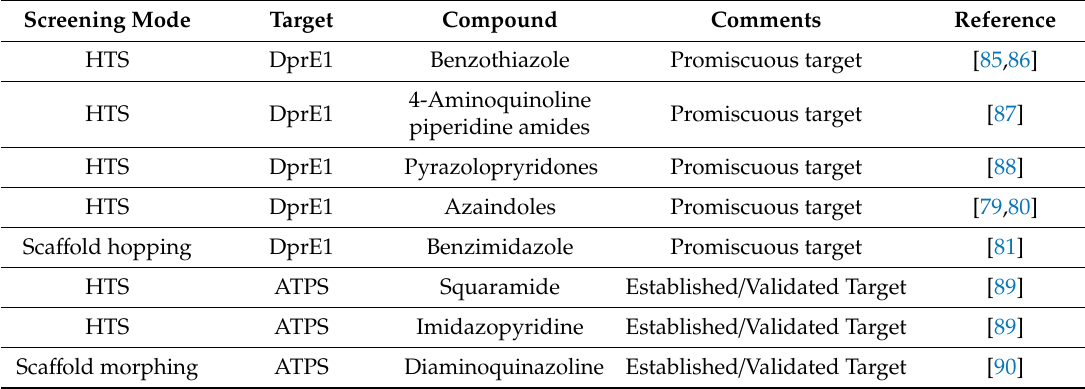
Table 3. Phenotypic screening-based efforts at AstraZeneca India (AZI).